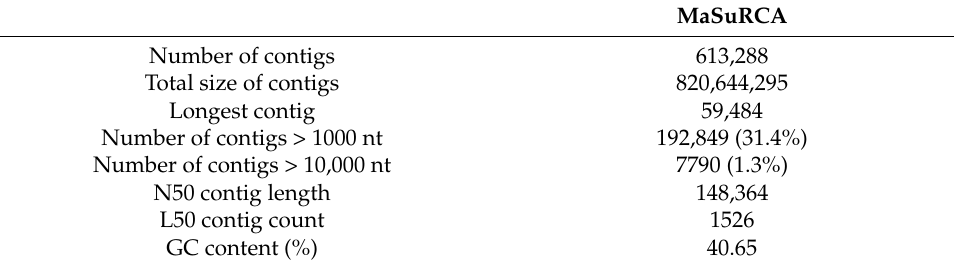
Table 3. Statistics of T. loennbergii assembled genome sequences.